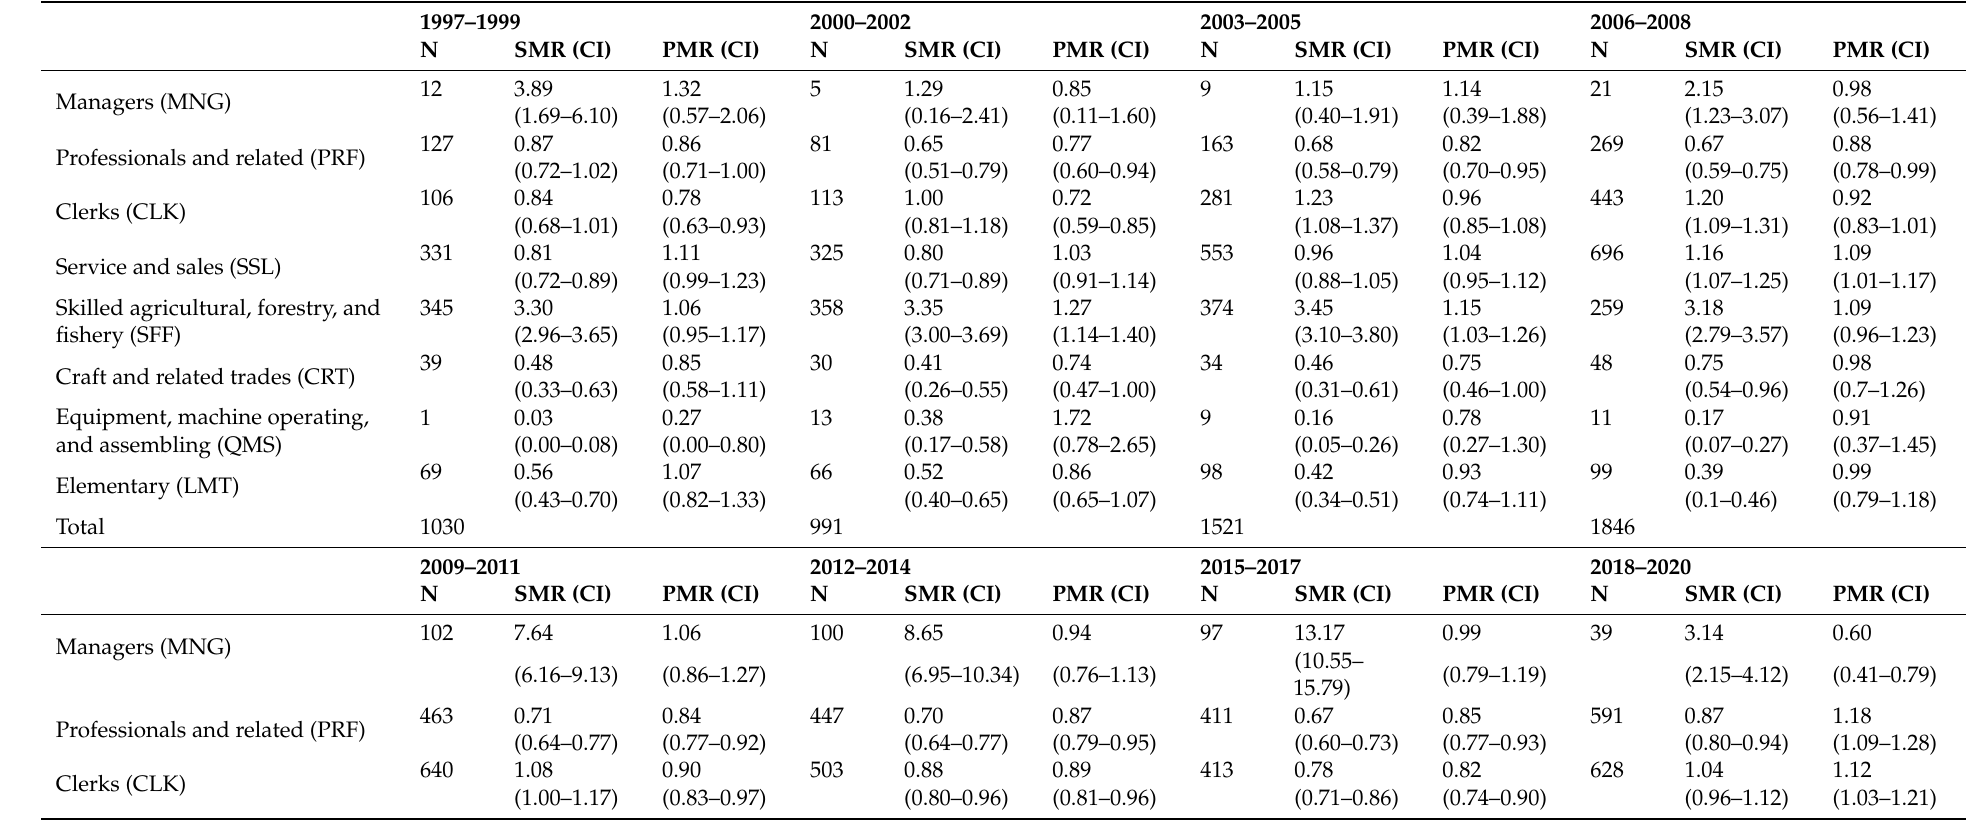
Table 2. SMR and PMR of female suicide by occupation, every 3